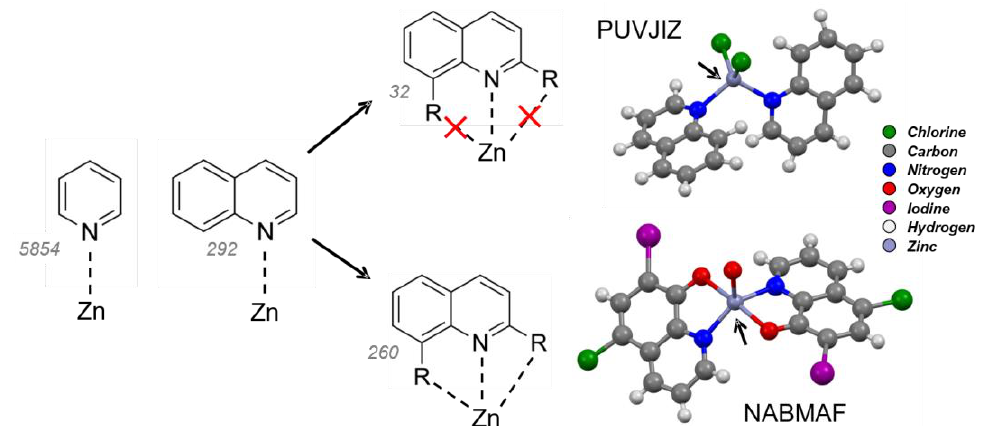
Figure 1. Cambridge Structural Database search for quinoline–zinc complexes with important structural features highlighted in two representative examples with CSD reference codes marked. Counts represent structures containing zinc based on the following criteria: contact inter/intra-molecular bonding (separated by 1–3 bonds 0.5–4.0 Å), R-factor < 0.05, non-disordered, no errors, single crystal structures and organometallic.